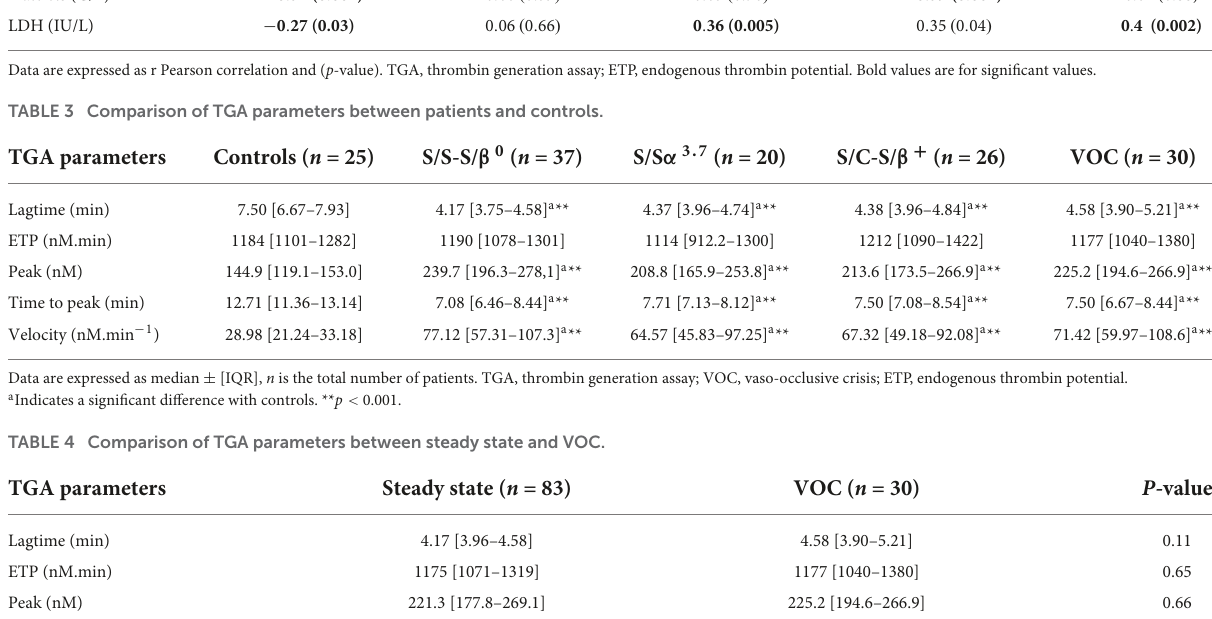
Lagtime r ( p- value)